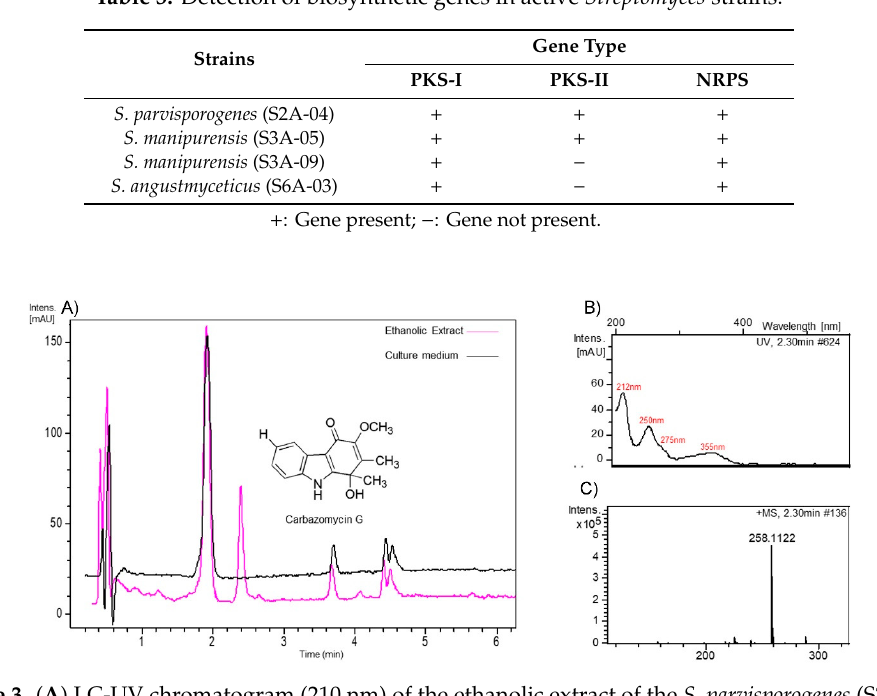
Figure 3. ( A ) LC-UV chromatogram (210 nm) of the ethanolic extract of the S. parvisporogenes (S2A- 04) strain vs. an extract of the non-fermented culture medium, ( B ) Ultraviolet spectra and ( C )